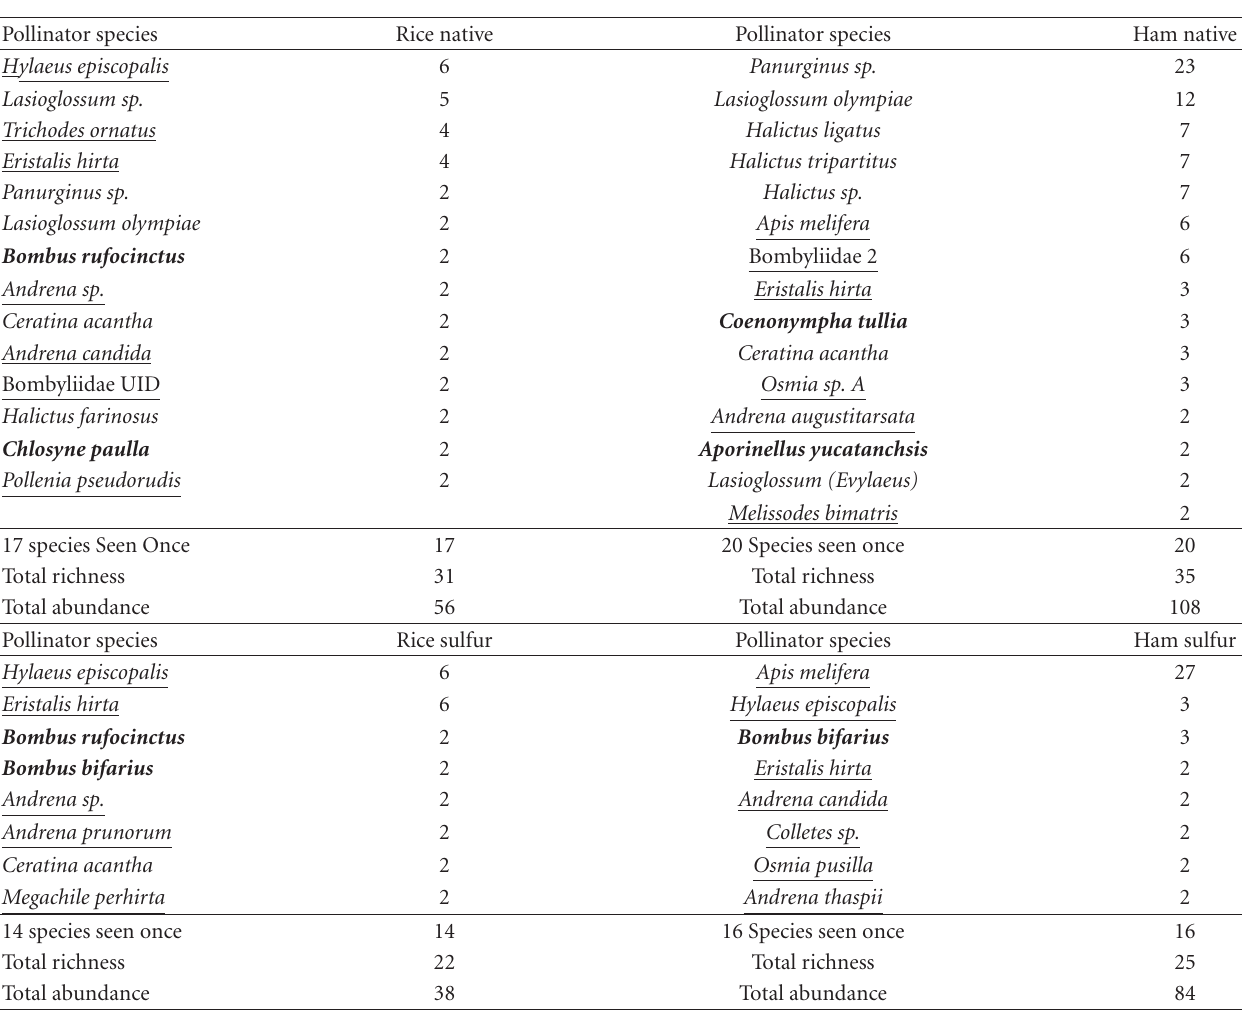
Table 5: List of pollinator species observed more than once, in order of abundance, for the 2003 flowering season at Ham and Rice sites, at Potentilla recta (exotic) and Potentilla gracilis (native) flowers, throughout the duration of the pollinator exclusion experiment conducted at these two sites, in June and early July 2003. Bold face refers to large bodied individuals, underline refers to medium bodied individuals, and light face refers to small bodied